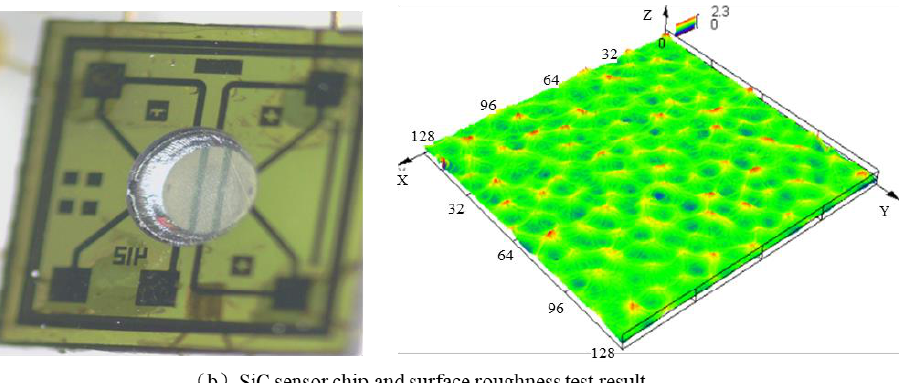
Figure 8. ( a ) SEM photograph of back cavity morphology after femtosecond laser etching, ( b ) SiC sensor chip and surface roughness test result.